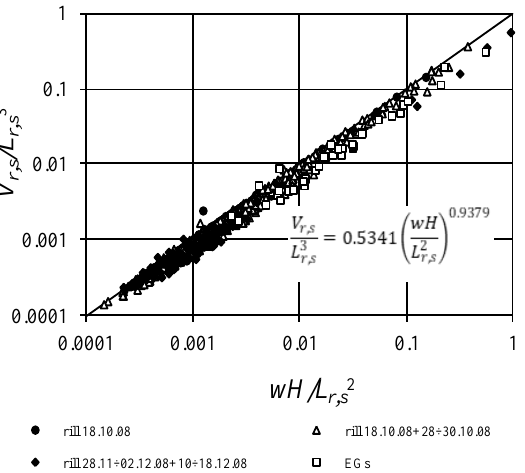
Figure 14. Relationship between the total length, L , and the total volume, V , for rills, EGs, and gullies (modified from [1]).